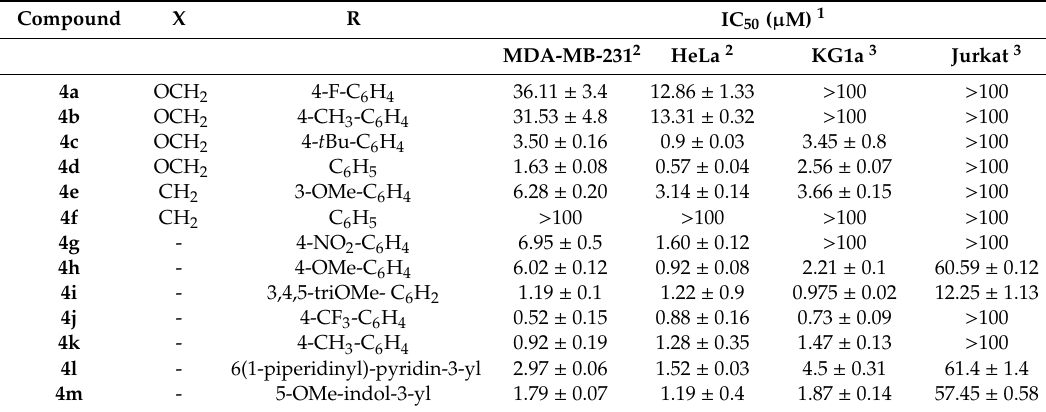
Table 1. In vitro anti-proliferative activity of 2-(1H-indol-3-yl)-5-substituted-1,3,4-oxadiazoles 4a–m in the MDA-MB-231 (metastatic breast), HeLa (cervical), KG1a (AML) and Jurkat (T-cell leukemia) human cancer cell lines.